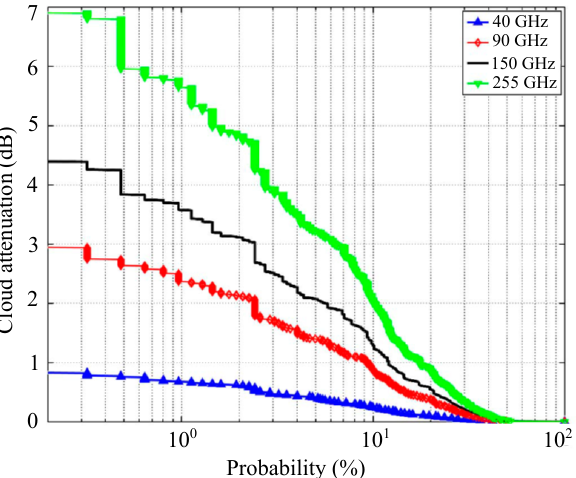
Figure 2. Empirical CCDF of zenith cloud attenuation